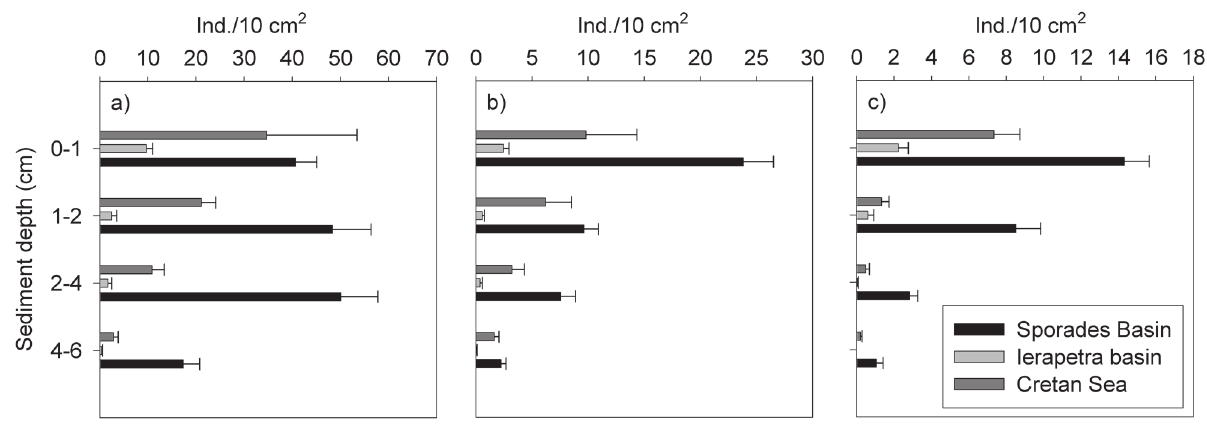
Fig . 3. – mean vertical (individuals per 10 cm 2 ± se) of (a) nematodes, (b) foraminifera and (c) copepods (adults and nauplii) at the three sampling